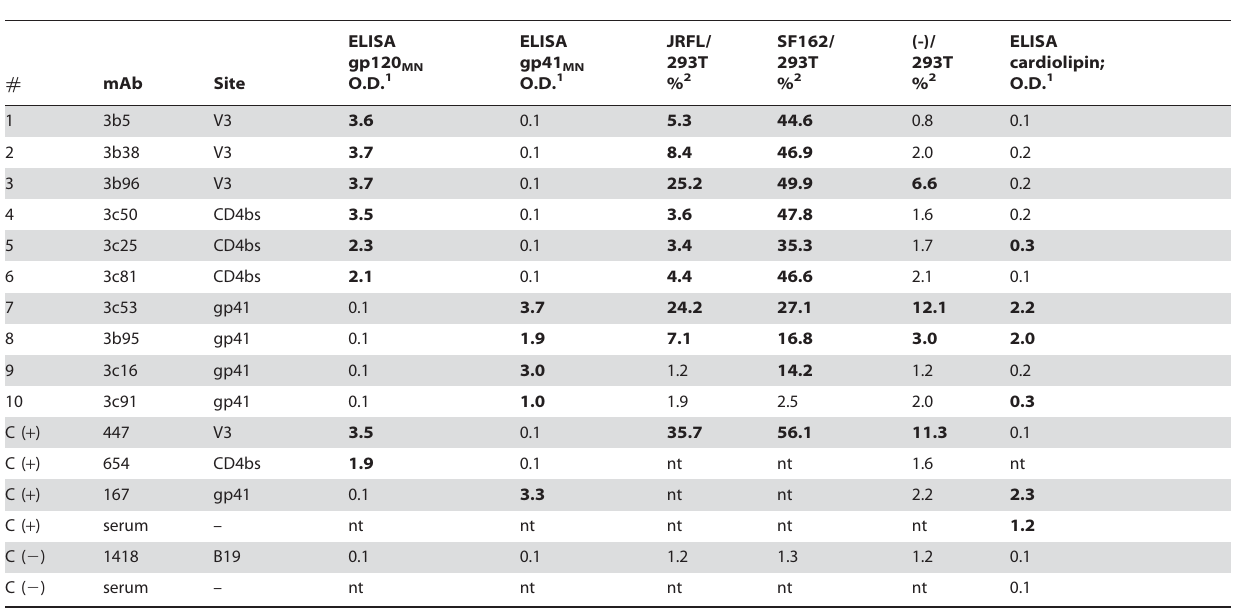
1 A standard ELISA was used to determine the binding activity of mAbs to antigens. Monoclonal Abs were tested at a concentration of 10 m g/ml against gp120 and gp41 coated onto ELISA plate at 1 m g/ml; cardiolipin at a concentration of 45 m g/ml in ethanol was coated by evaporation at 4 u C overnight. The numbers are O.D. values; bold numbers indicate specific reactivity based on value above cutoff which was defined as the mean binding of mAb 1418 (specific to parvovirus B19) + 3 standard deviations. 2 Flow cytometry was used to measure the mAb binding to JRFL, SF162 Env-transfected 293T cells and native 293T cells as control. The bold numbers indicate percent of cells specifically reactive with mAbs based on values above cutoff determined with irrelevant mAb 1418 as described above. C( + ) – positive control; C(-) – negative control; nt – not tested.